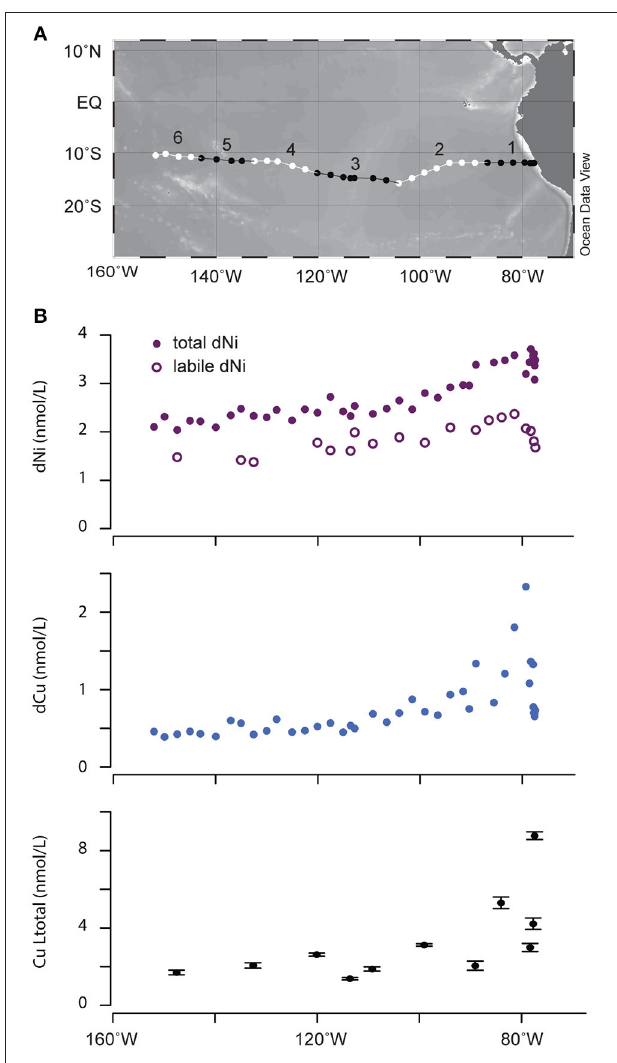
FIGURE 1 | (A) Map of GEOTRACES EPZT section. Alternating black and white lines indicate the six legs over which integrated samples were collected. (B) Surface concentrations of dissolved Ni, Cu, and Cu ligands. Error bars represent ± 1 standard deviation based on replicate measurements of Cu ligand